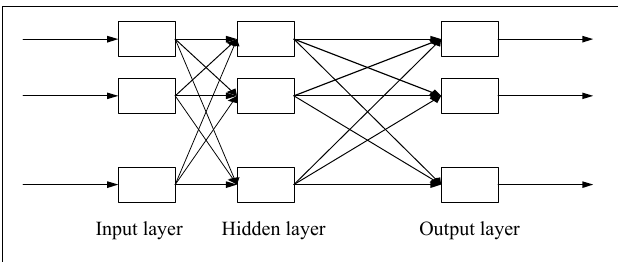
FIGURE 1 | Three-layer model of